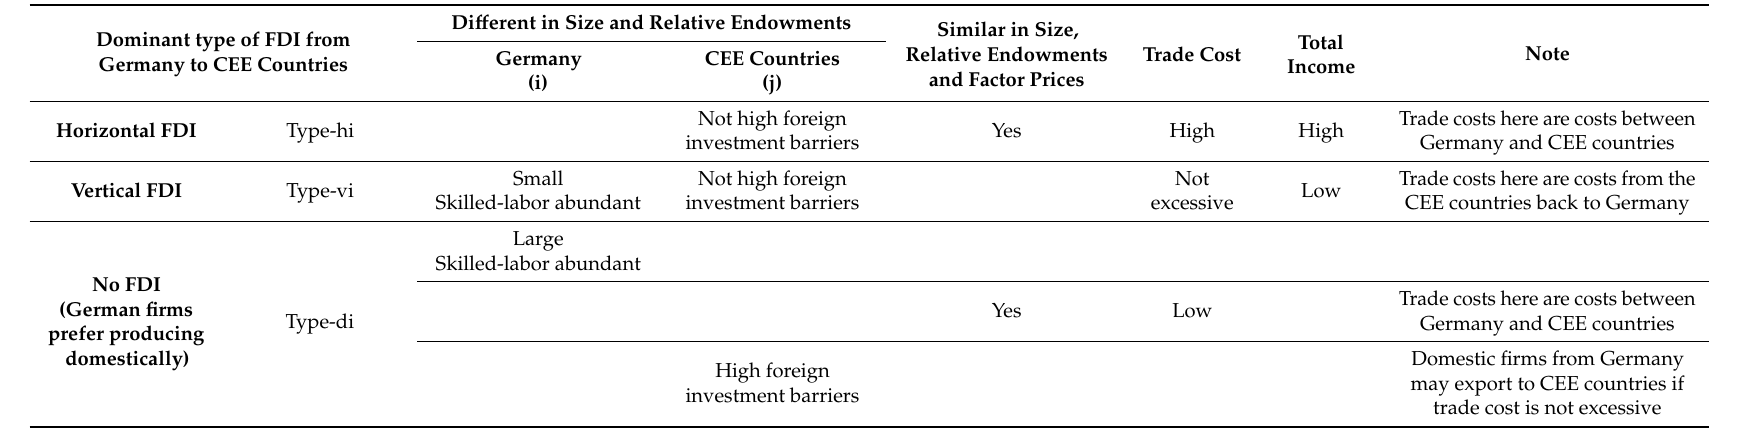
Table 1. Types of foreign direct investment (FDI) from Germany to Central and Eastern Europe (CEE) and countries’ characteristics. Dominant type of FDI from Germany to CEE